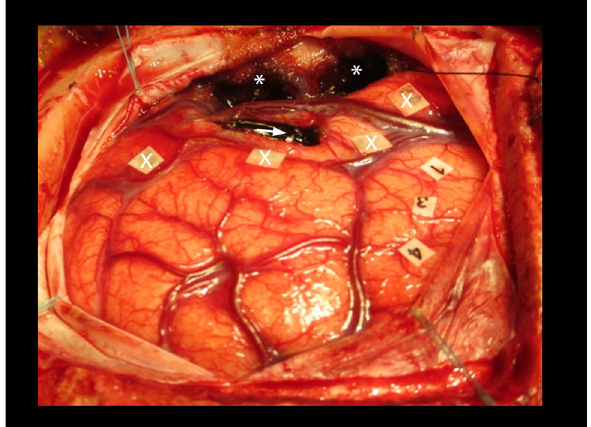
Fig. 3 Intraoperative photograph of the resected tumor (*), sono- graphic tumor boarders ( X ) and speech eloquence during direct cortical stimulation (numbers 1, 3 and 4). The arrow marks the area not amenable for